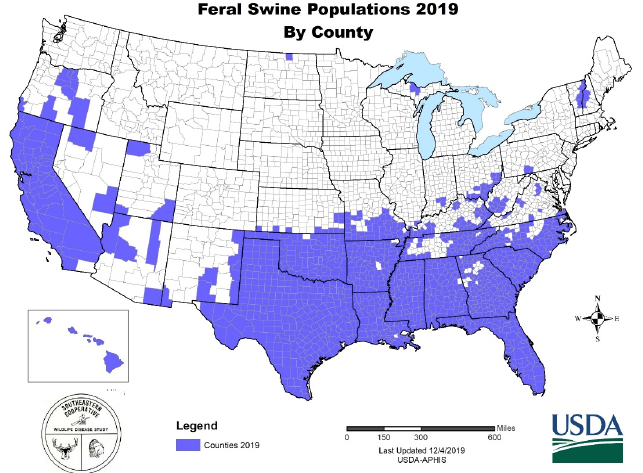
Figure 2. Feral Swine Populations 2019 by County. Reproduced with permission from USDA- APHIS,